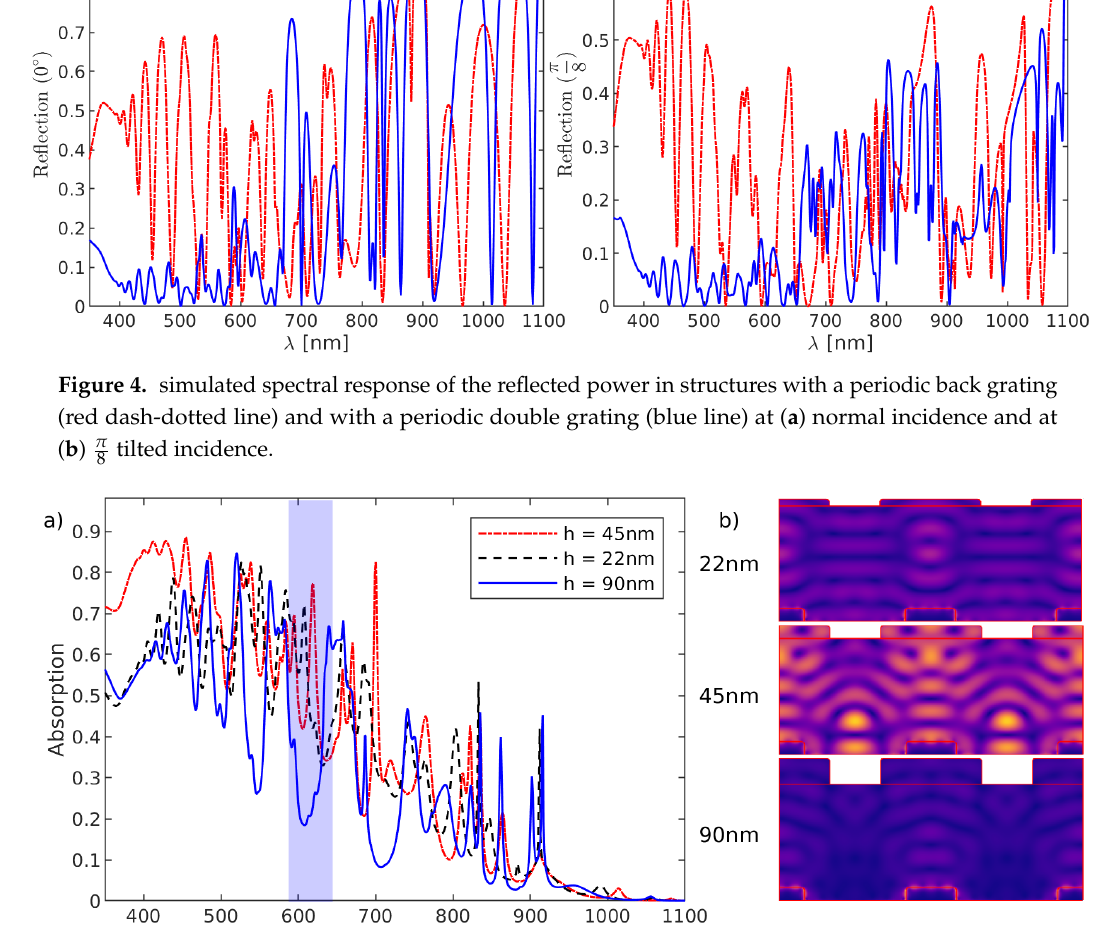
Figure 5. ( a ) simulated spectral response of the active layer’s optical absorption in structures with a periodic double grating and tooth heights of 90 nm (solid blue line), 45 nm (red dash-dotted line) and 22 nm (black dashed line); ( b ) simulated electric field distributions at the operating wavelength of 620 nm highlighted in the graph ( a ), for all mentioned tooth